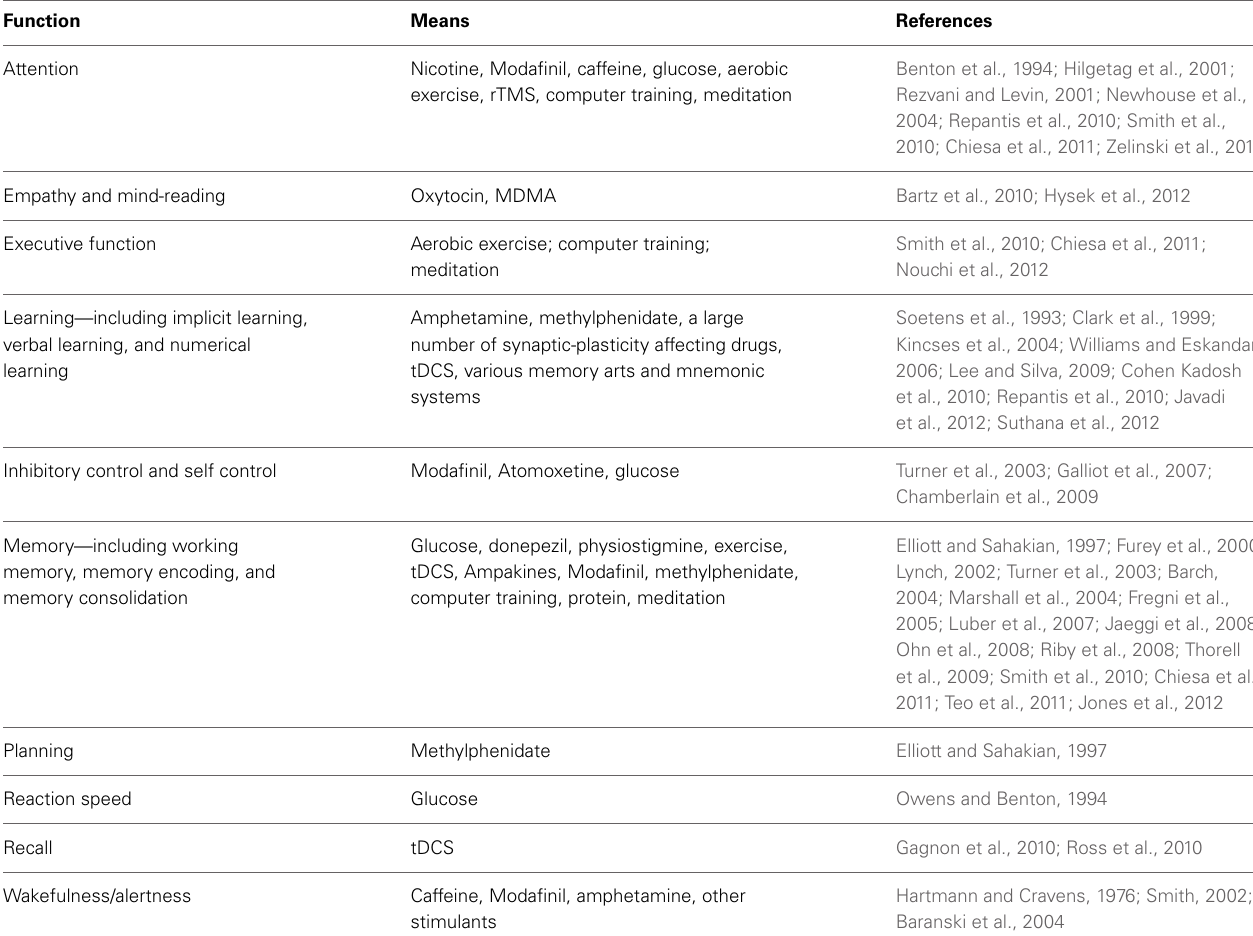
Table 1 | Selective summary of “augmentative” neural enhancements, means, and references.